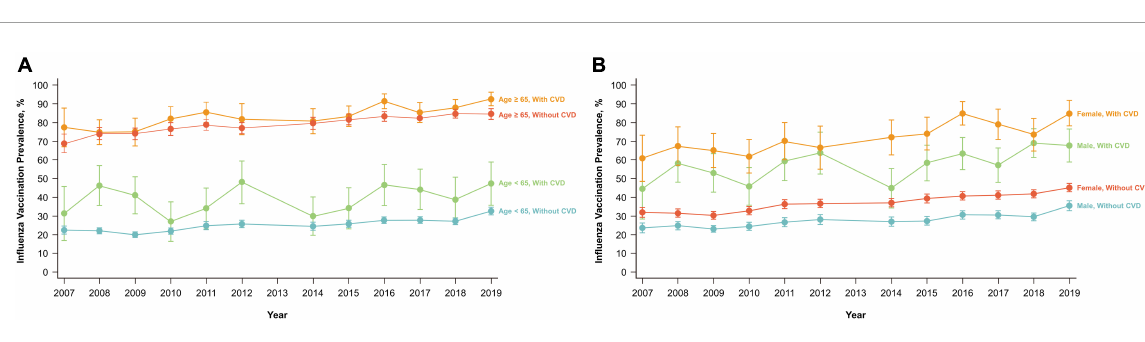
FIGURE3 Influenza vaccination trends over 9 years according to the cardiovascular disease history. (A) Age ( < 65 and ≥ 65 years). (B) Sex (male and female). CVD, cardiovascular